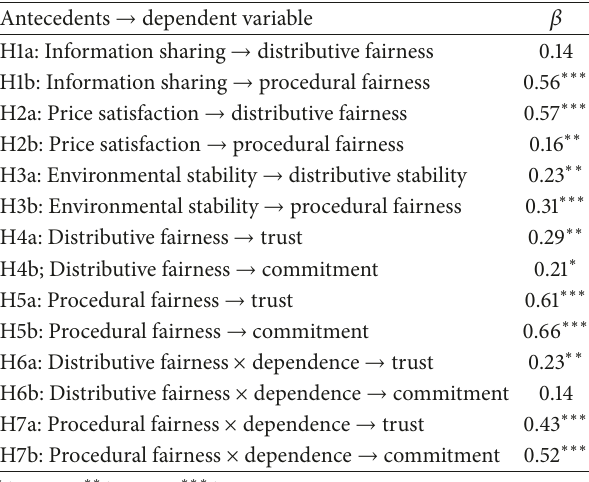
Table 3: Results of hypothesis